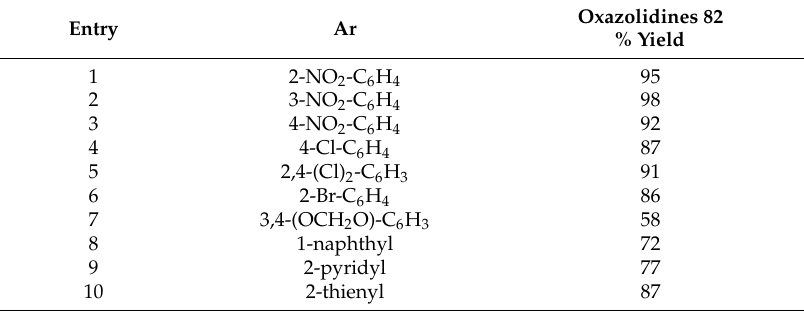
Table 11. Cycloaddition of azomethine ylide 81 to aldehydes 2 (Scheme 19).